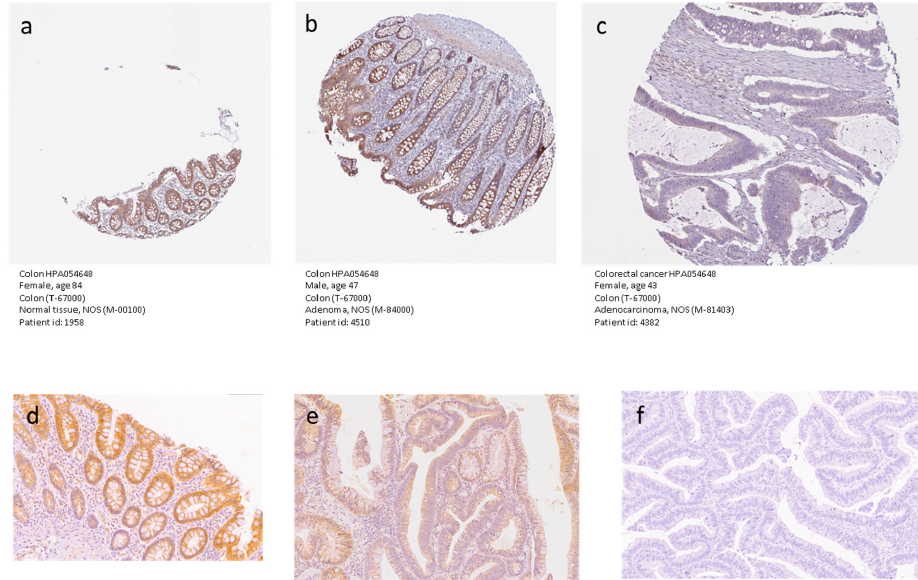
Figure 4. Immunohistochemical analysis for KCNMA1 protein expression in samples of normal colonic mucosa ( a ), adenoma ( b ), and adenocarcinoma ( c ). The images obtained from The Human Protein Atlas database (https://www.proteinatlas.org/pathology). Immunohistochemical analysis for KCNMA1 protein expression in samples of normal colonic mucosa ( d ), tubule-villous adenoma with low-grade dysplasia ( e ), and adenocarcinoma ( f ). Magnification for all images: 20 × .